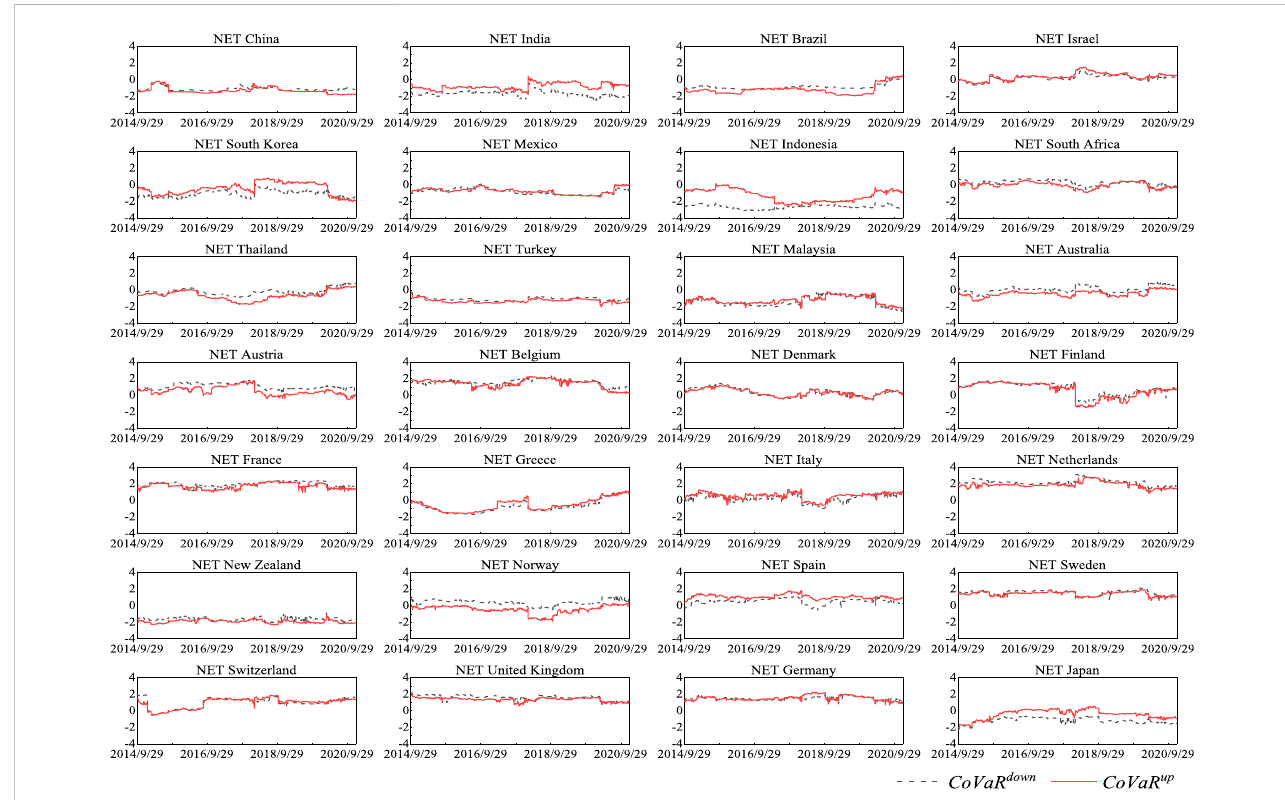
FIGURE 5 Net spillovers (2nd commitment period). Note: The unit of the vertical axis is